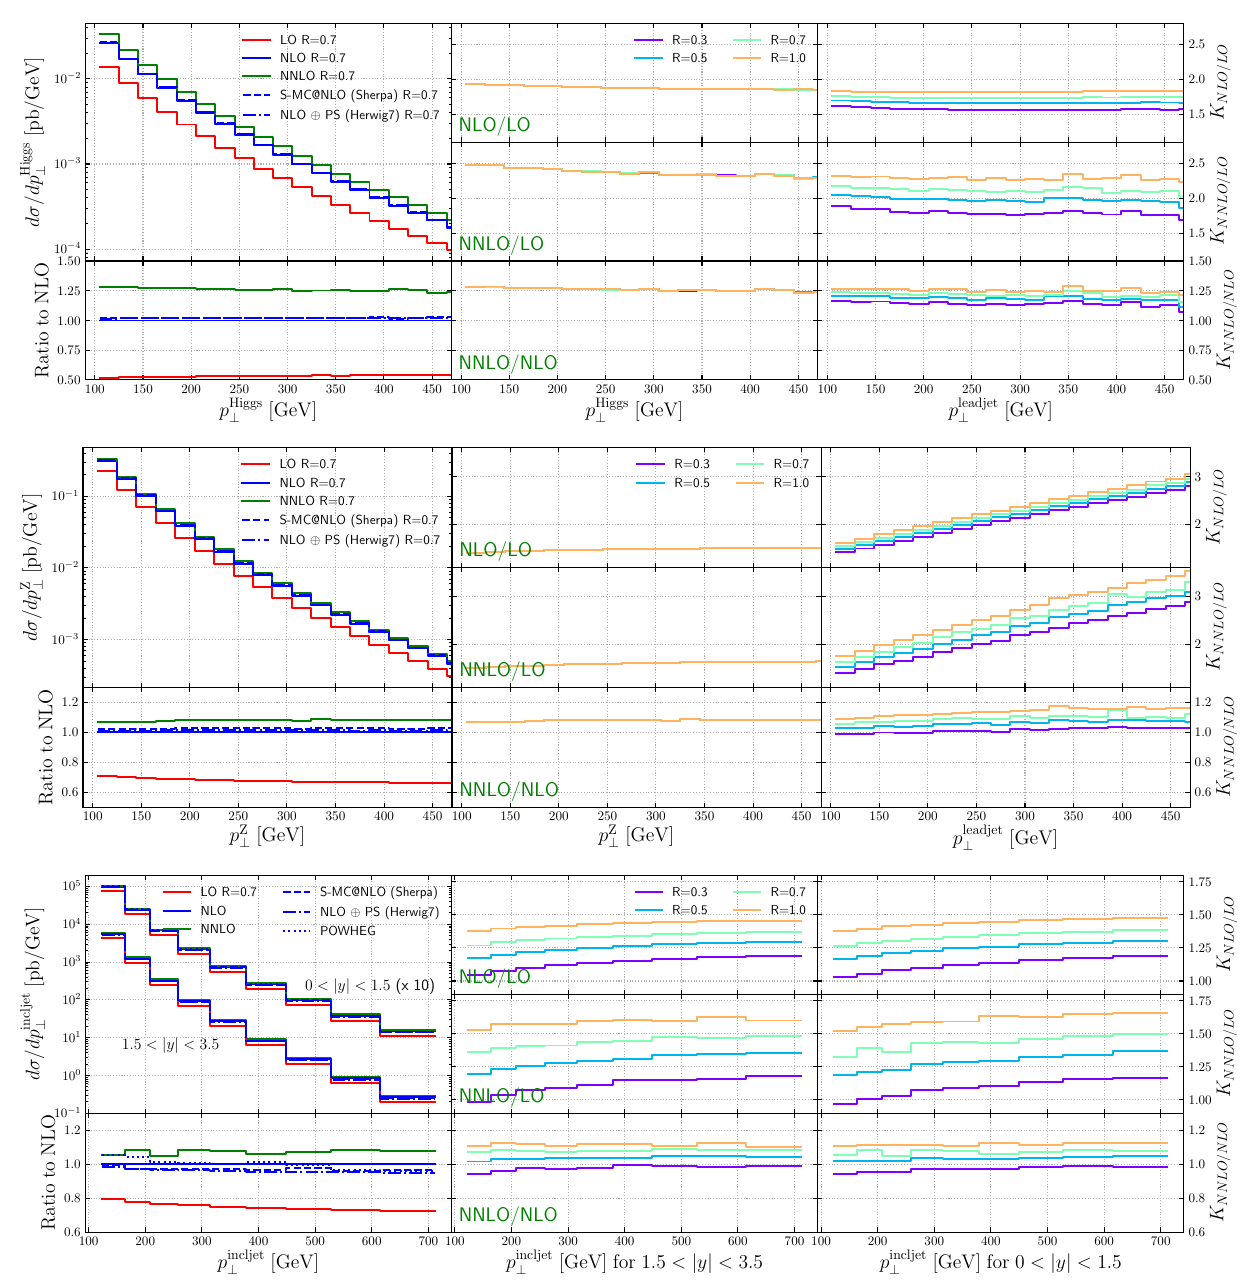
Fig. 2 K -factors for Higgs plus jets (top), Z plus jets (middle) and inclusive jet production